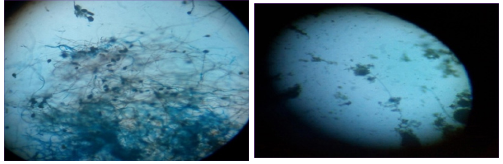
Fig. 2. 10x observation Fig. 3. 40x observation